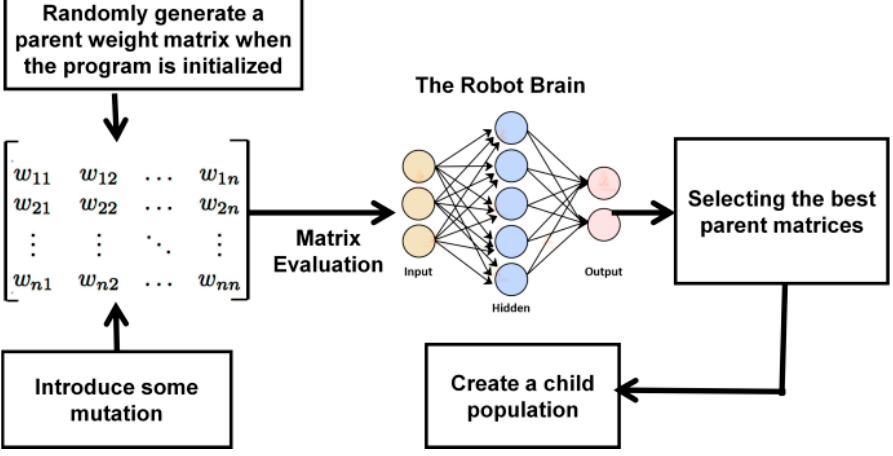
Figure 1. The block diagram of the controller evolution.